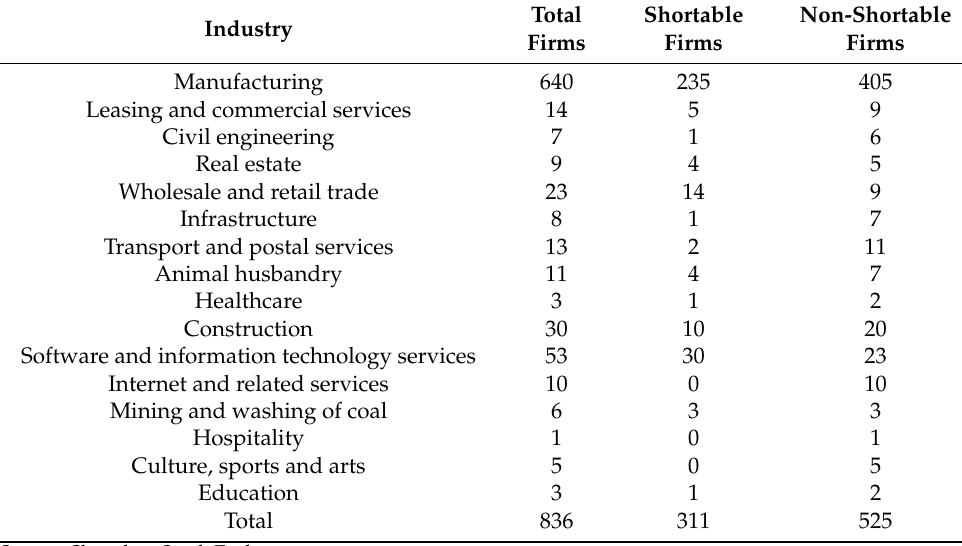
Table 3. Distribution of sample by industry.